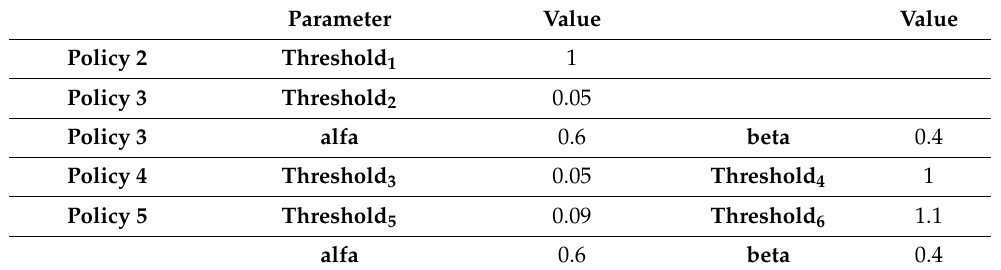
Table 4. Parameters for the switch-off policies.